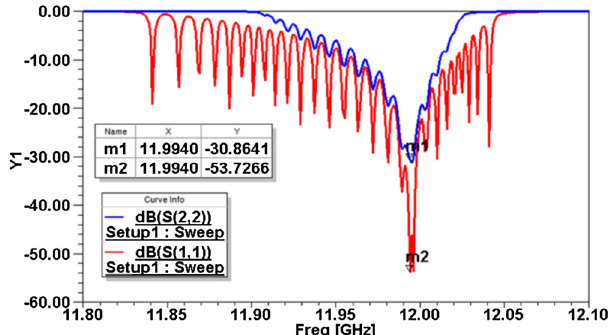
FIG. 15. Port-reflection of new CLIC-G tapered structure (HFSS simulations).